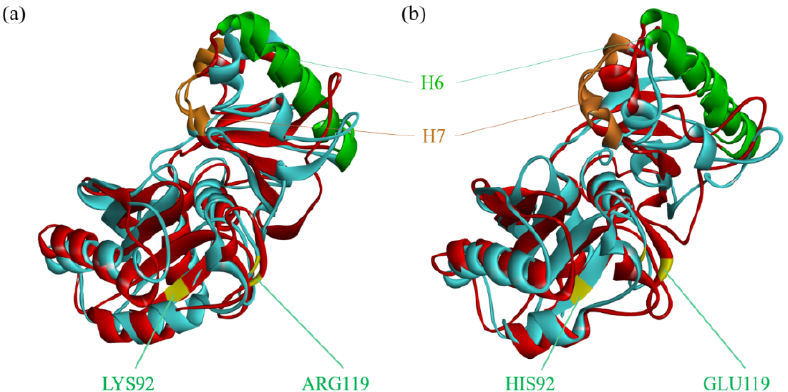
Figure 8. Structural comparison of WT and H92K/E119R at different temperatures after 100 ns MD. The area with larger local RMSD is marked. ( a ) Structural contrast of H92K/E119R at 300 K and 360 K ( b ) Structural contrast of WT at 300 K and 360 K.